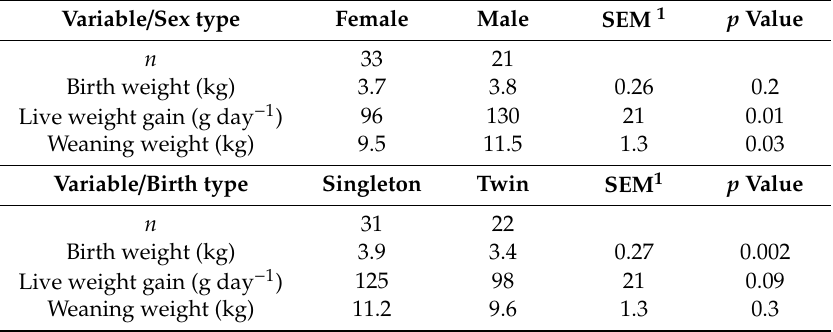
Table 2. Combined data for all the lambs from all Rambouillet ewes in all treatment groups (Control, Opuntia and E-Opuntia) showing the e ff ects of sex and birth type on birth weight, daily live weight gain, and weaning